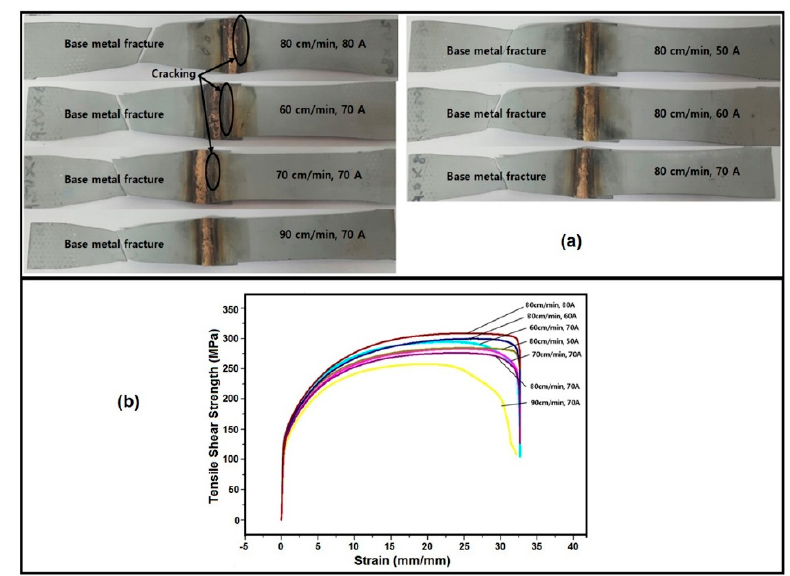
Figure 10. ( a ) Post-test photographs of the tensile samples, and ( b ) Tensile shear stress-strain curves of the various joints.